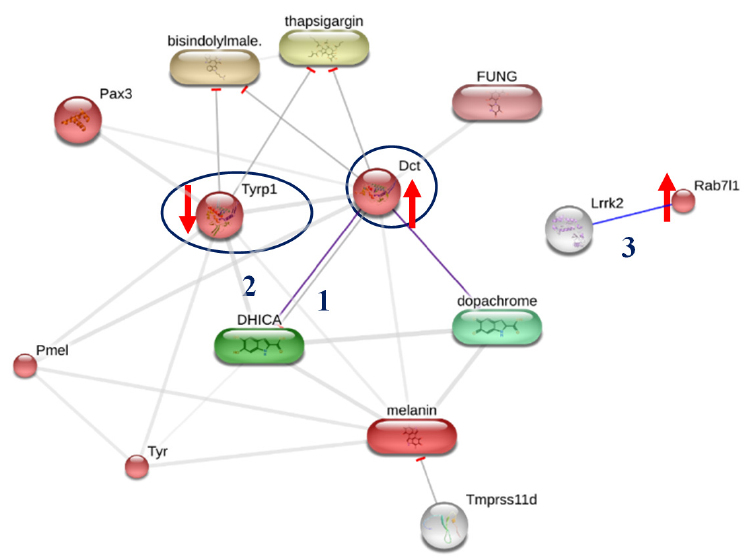
Figure 6. The protein network established by the STITCH protein–ligand interaction (http://stitch.embl.de; accessed on 29 August 2021). Three proteins from the proteomics analysis (Tyrp1, Dct, and RAb7la) were used to construct their interaction. Tyrp1 and Dct are associated with melanin production via DHICA, dopachrome, and Tyr protein. Up-arrow and down-arrow indicated the up- and down-regulation in the octapeptide treatment group.